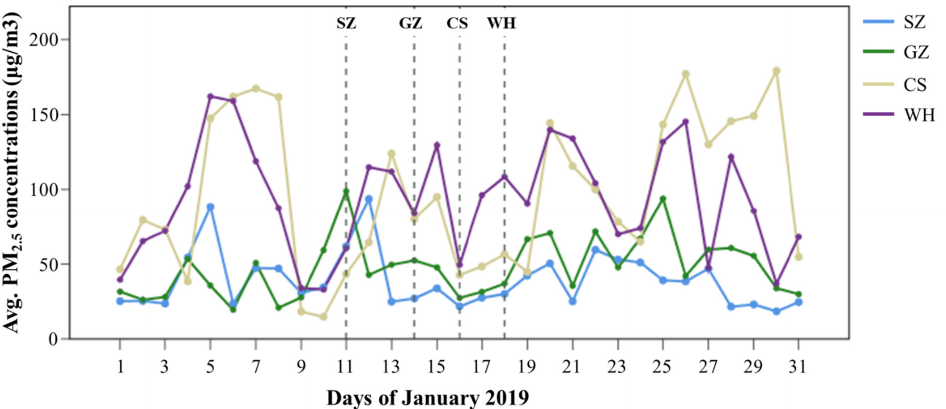
Figure 2. Urban ambient PM 2.5 concentrations measured by fixed urban monitoring stations in the four cities in January 2019 (7:00–20:00).